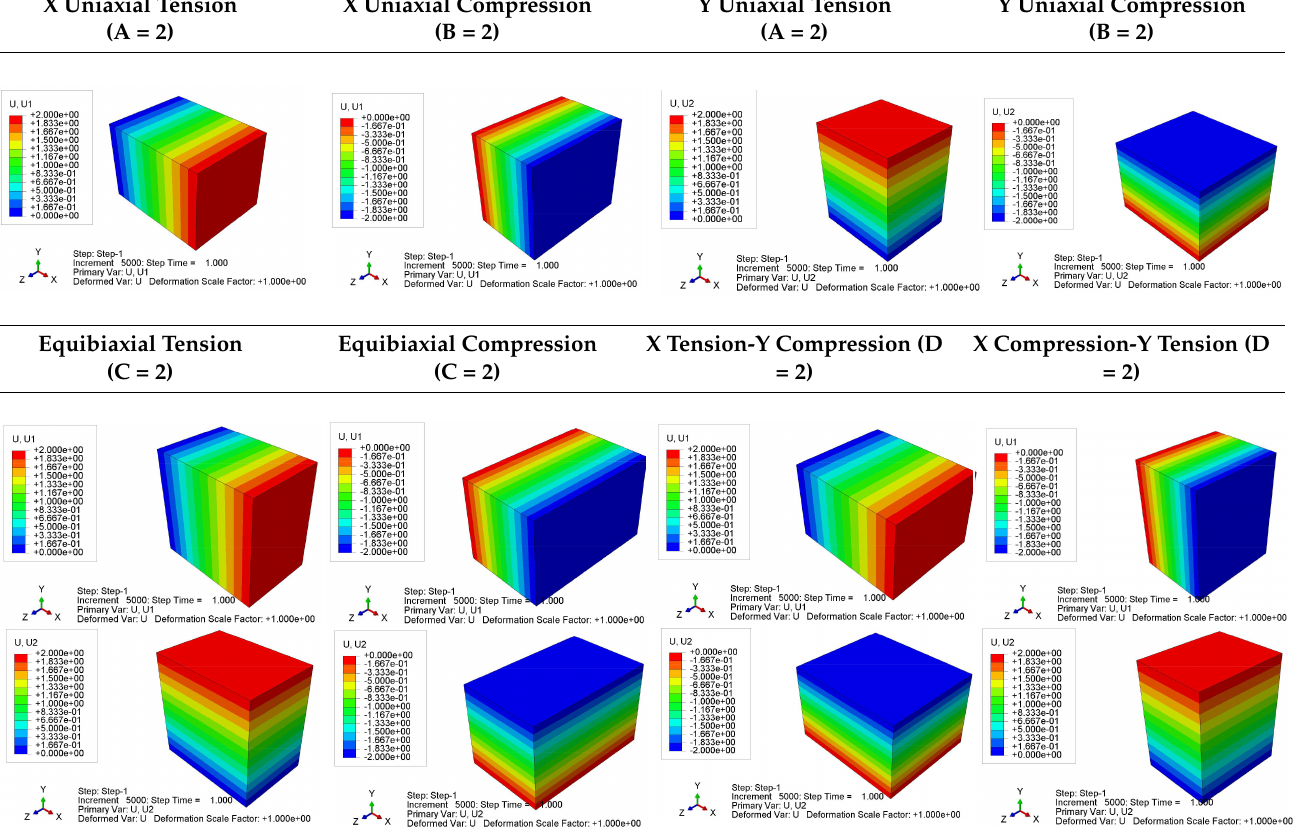
Table 3. Displacement contours of deformed specimens under uniaxial and biaxial loading (unit: mm). X Uniaxial Tension